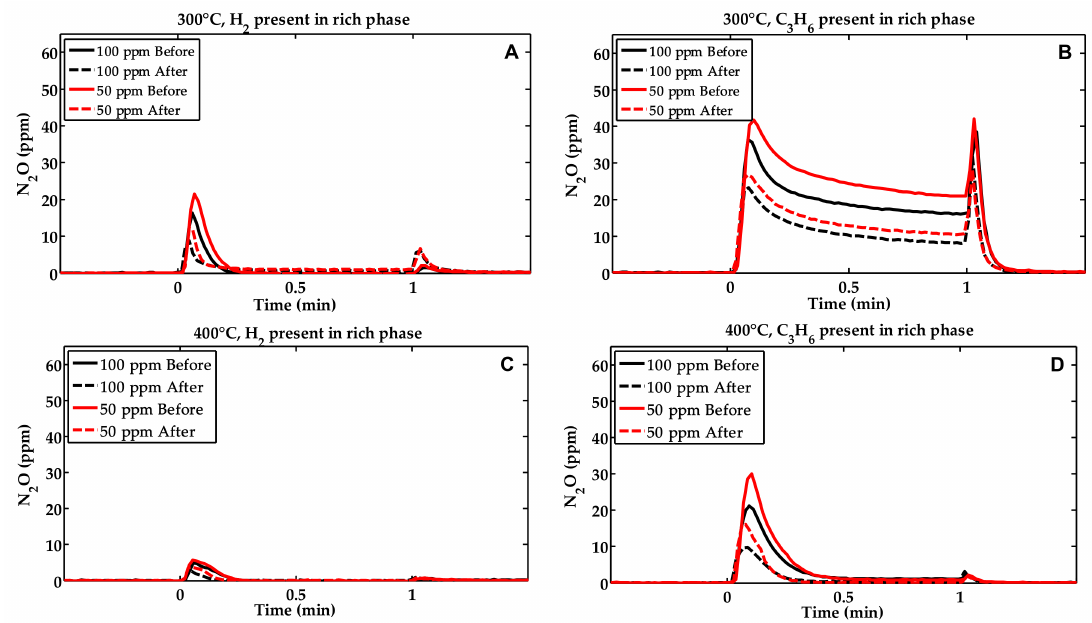
Figure 3. Measured outlet N 2 O before and after exposing Pt/Ba/Al 2 O 3 to 50 or 100 vol.-ppm H 3 PO 4 , 8 vol.-% O 2 and 5 vol.-% H 2 O for 34 h. The rich phase (400 vol.-ppm NO, 5 vol.-% H 2 O, 5 vol.-% CO 2 and H 2 or C 3 H 6 ) starts at time = 0. The lean phase consist of 400 vol.-ppm NO, 5 vol.-% H 2 O, 5 vol.-% CO 2 and 8 vol.-% O 2 , where ( A ) 300 ◦ C with 1 vol.-% H 2 in the rich phase, ( B ) 300 ◦ C with 0.1 vol.-% C 3 H 6 in the rich phase, ( C ) 400 ◦ C with 1 vol.-% H 2 in the rich phase, and ( D ) 400 ◦ C with 0.1